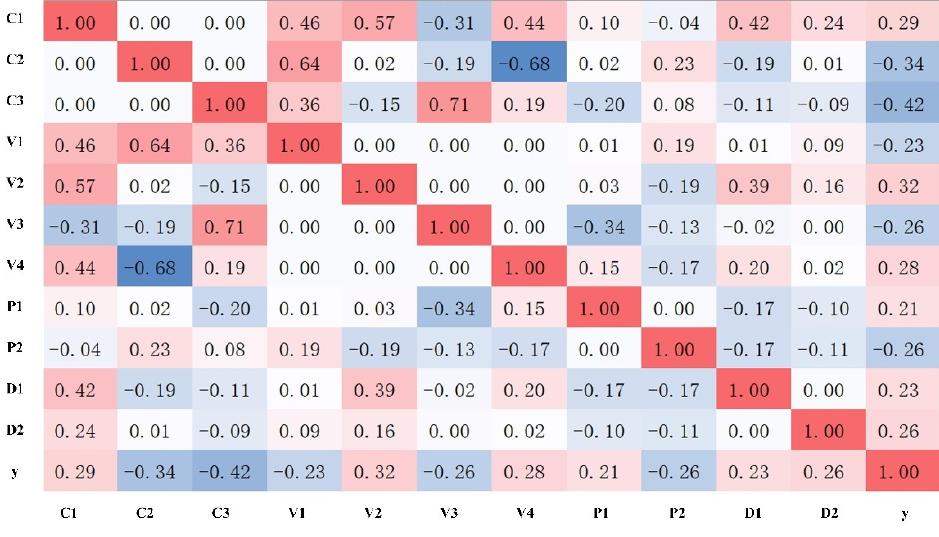
Figure 5. Components with a correlation coefficient greater than 0.2.